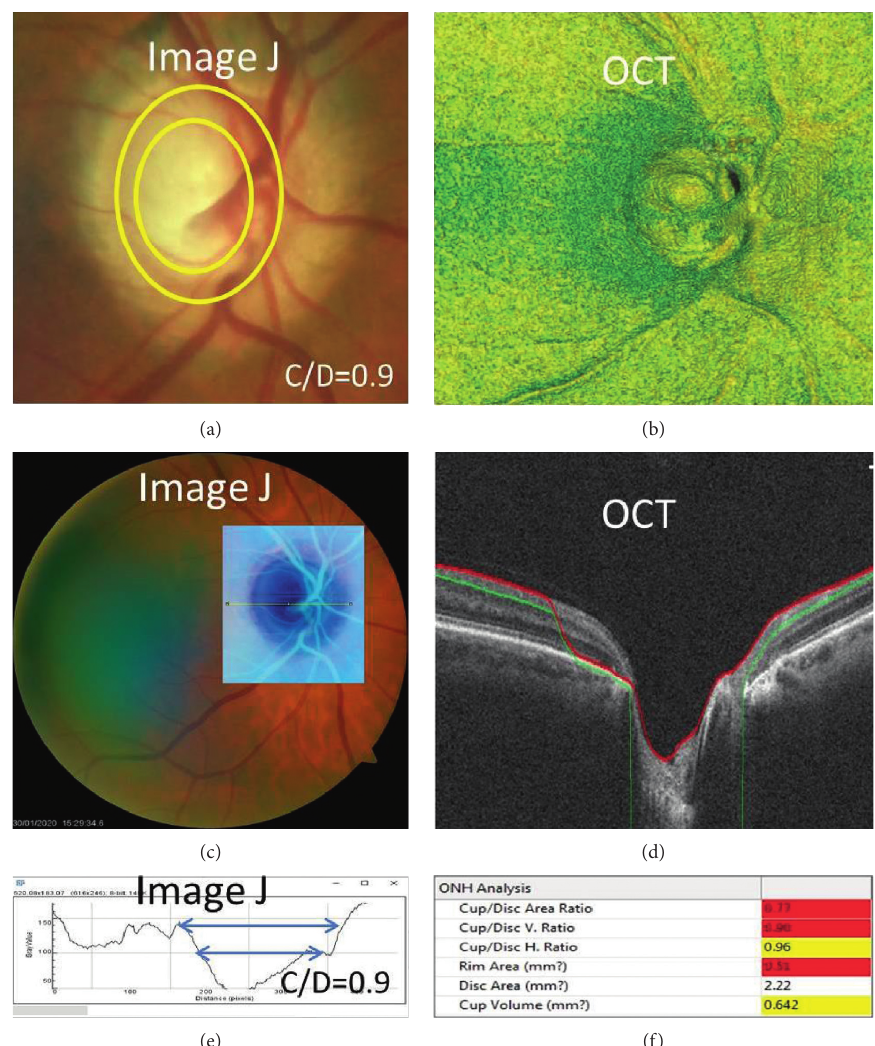
Figure 4: Resemblance of the ImageJ histogram and cup/disc (C/D) ratio based on the 3D fundus images compared to the analogous images obtained by